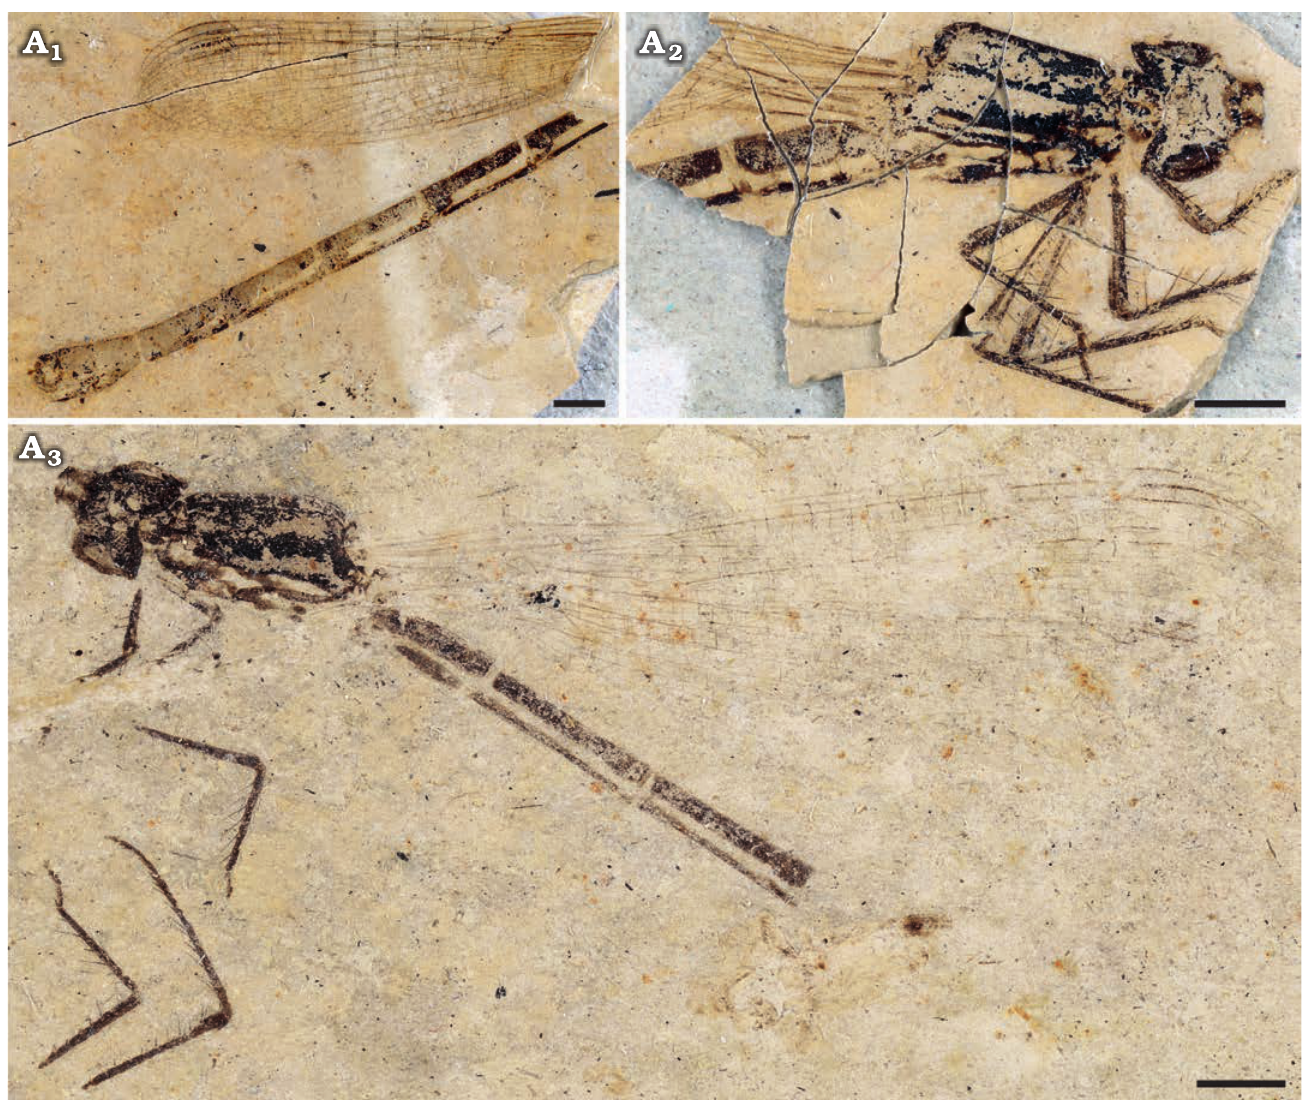
Fig. 12. Zygopteran odonatan Lestes ceresti Nel and Papazian, 1985, PNRL 2021; from Oligocene, Céreste, France. Imprint (A 1 , A 2 ), counterimprint (A 3 ). Scale bars 2